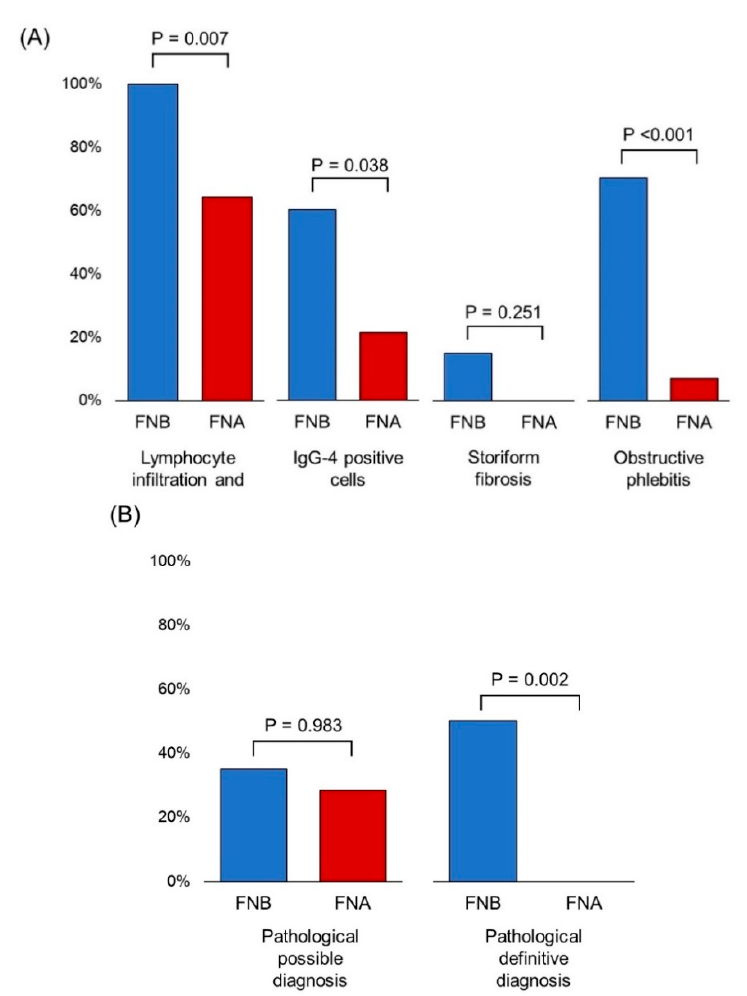
Figure 3. Comparison of the diagnostic yield of EUS-FNA / B among patients with probable and definitive AIP. ( A ) Comparison of the sensitivity for each typical histological finding of lymphoplasmacytic sclerosing pancreatitis. ( B ) Comparison of the sensitivity for pathological diagnosis. AIP, autoimmune pancreatitis; EUS-FNA / B, endoscopic ultrasonography-guided fine needle aspiration / biopsy.